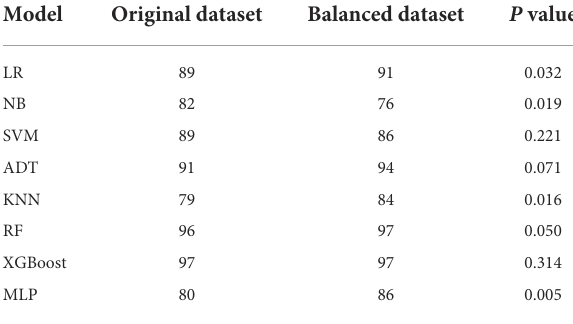
TABLE 6 AUCs of the various models before and after